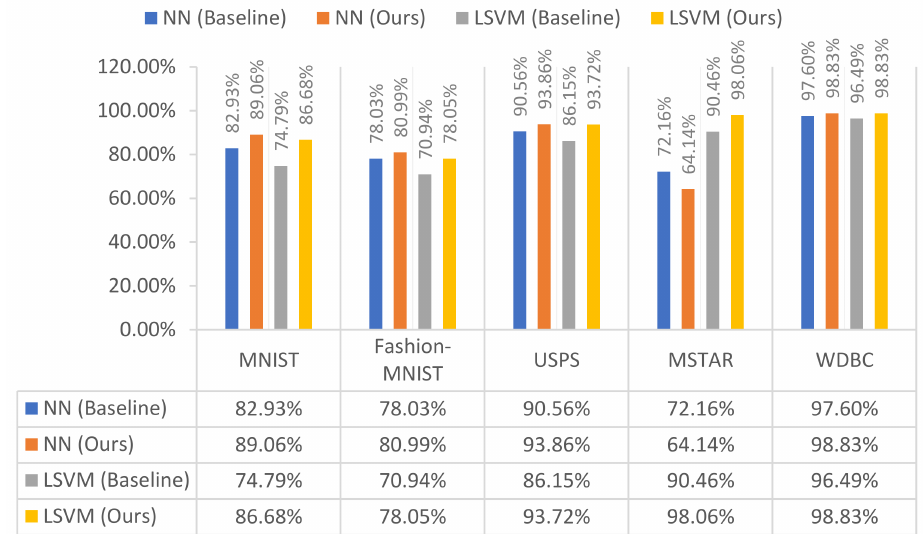
Figure 4. Classification accuracies on the five datasets.